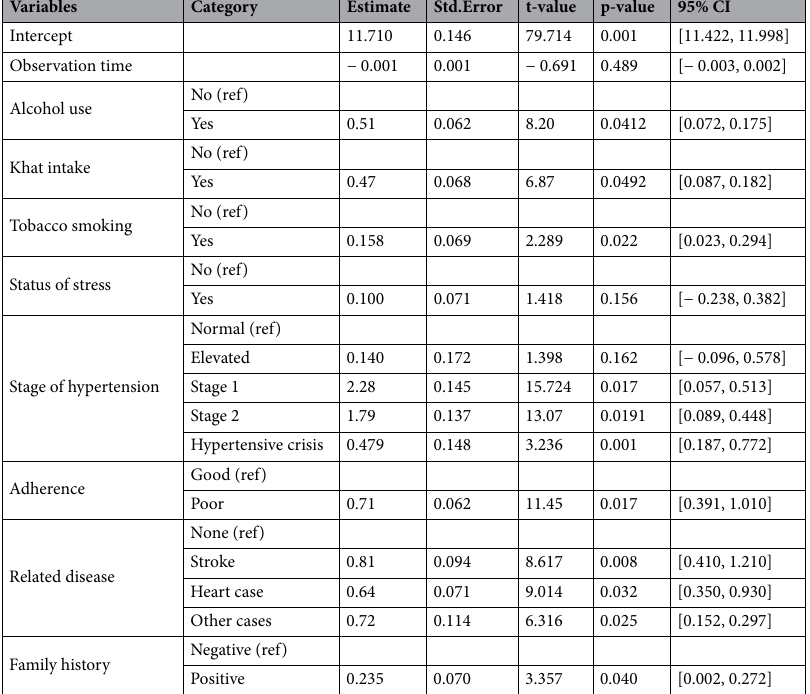
Table 3. Results of analysis of linear mixed effect model with random intercept.